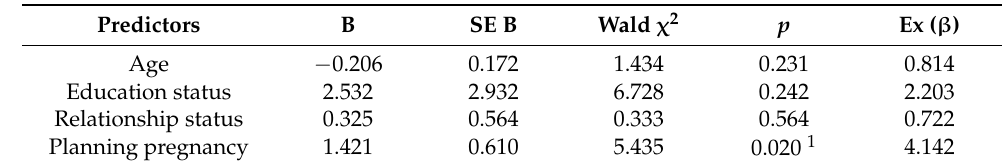
Table 4. Binomial logistic regression of demographic variables associated with social media use for preconception-related information.